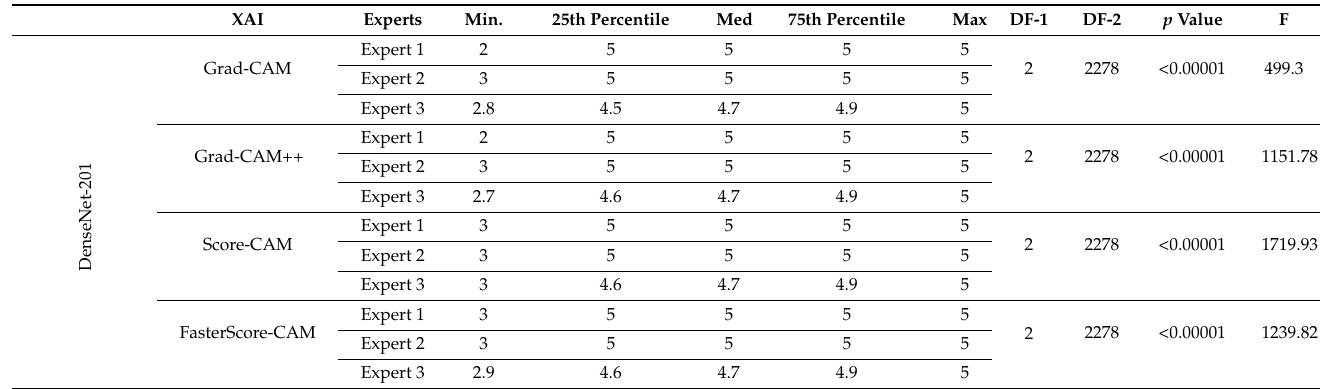
Table A3. Friedman test using DenseNet-201 model on the MAI score from three